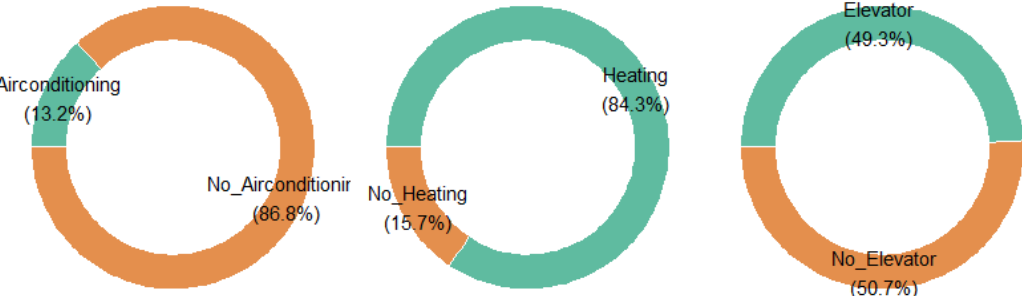
Figure 6. Basic services in the dwellings occupied by 65 years and over people in Lisbon, 2011. Source: Own elaboration, with data from Census records 2011.